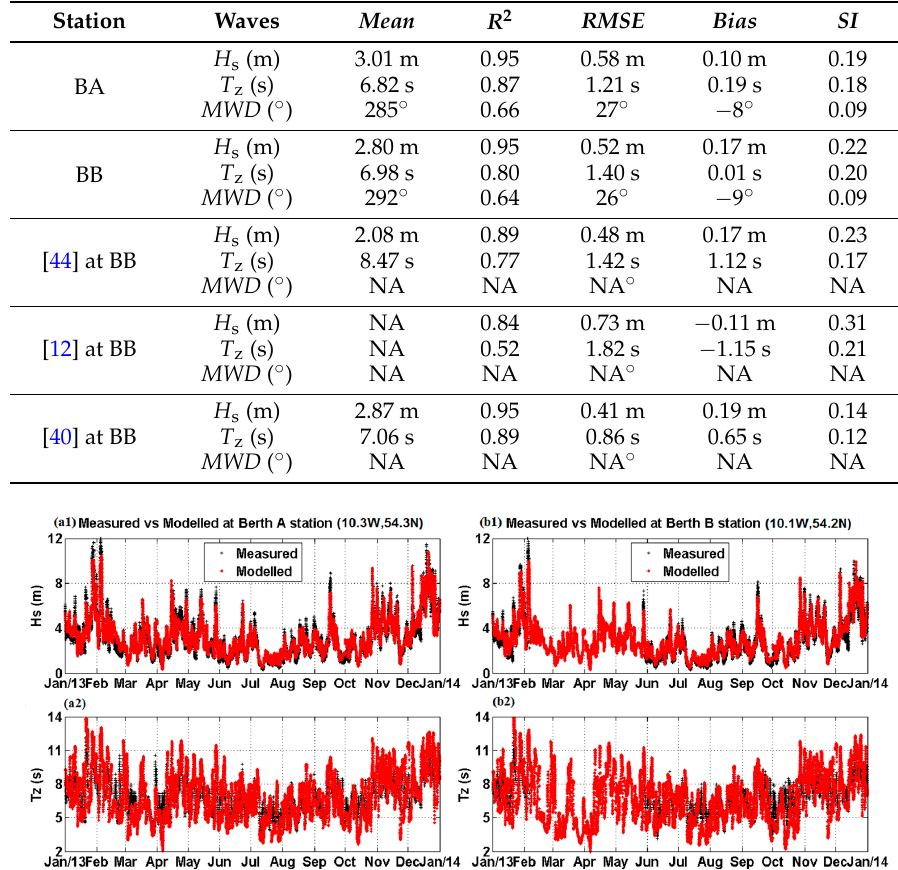
Table 3. Summary of AMETS model validation values and measured mean values at BA (2012–2013) and BB (2010–2013). NA indicates non-available data.